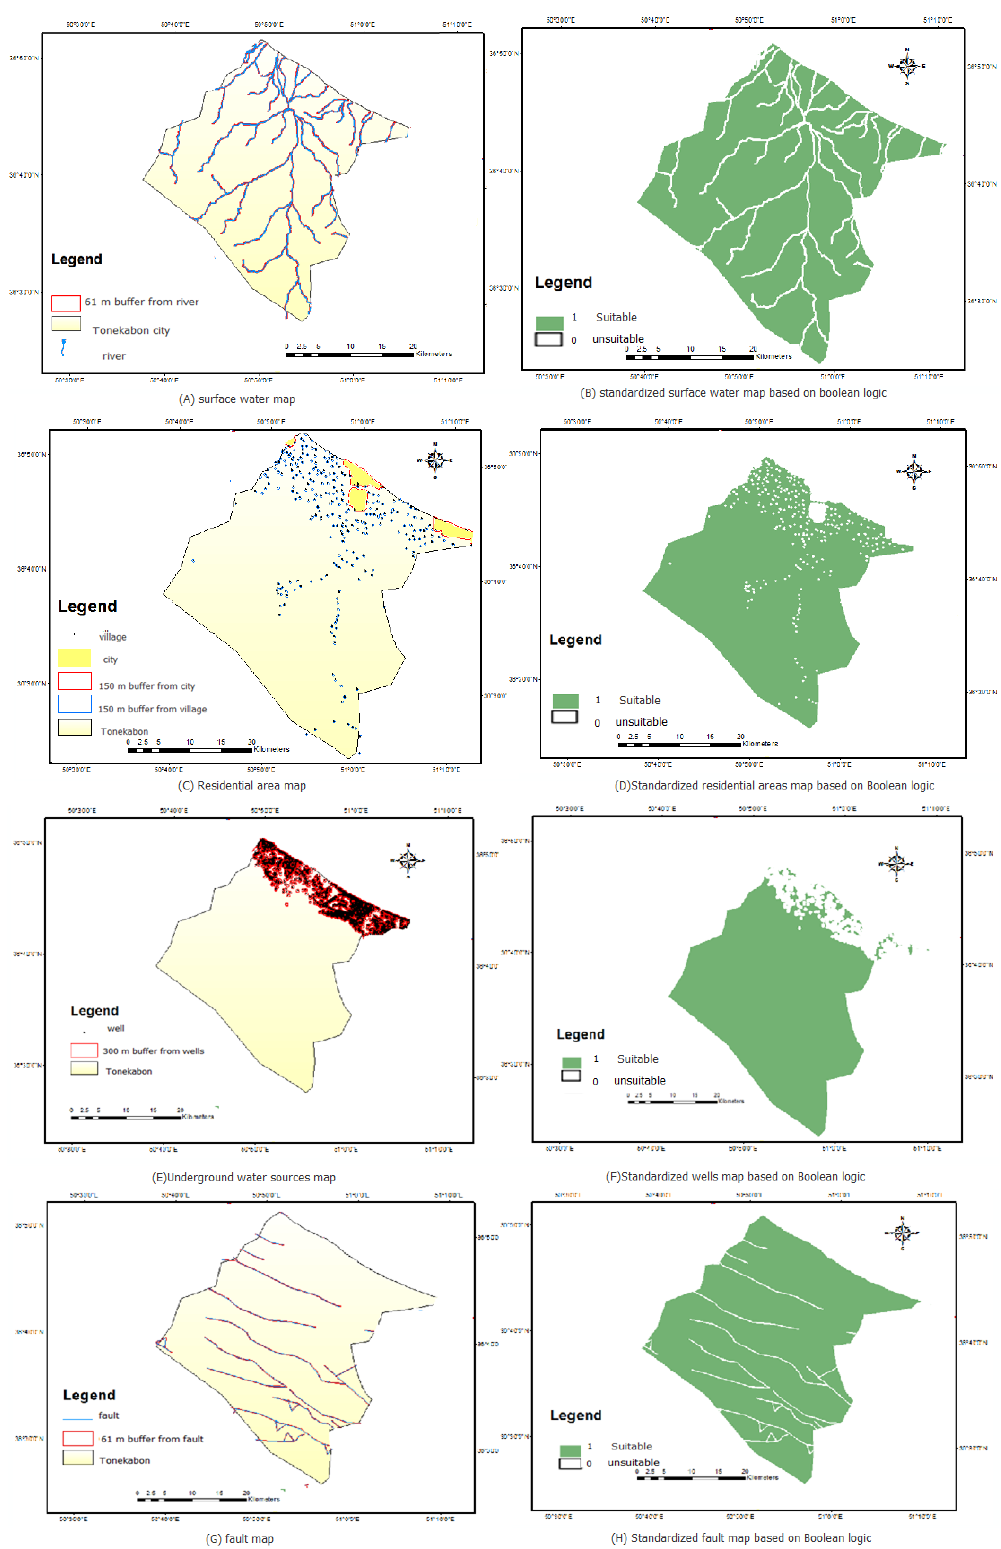
Figure 4. The constraint map layers used in the regional screening method and standardized maps based on Boolean